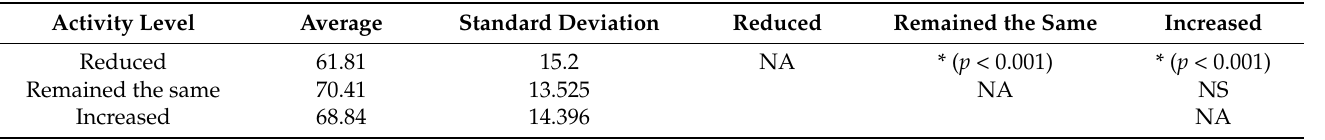
Table 2. Bonferroni multiple comparison test performed on three levels of overall physical activity in relation to the feeling of well-being ( n =